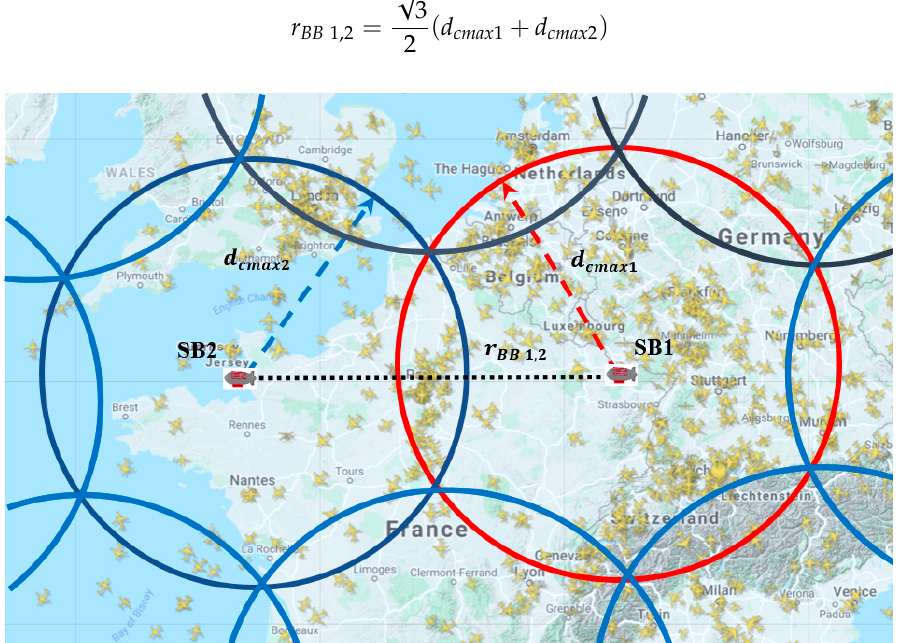
Figure 3. Cellular SB network for aviation.